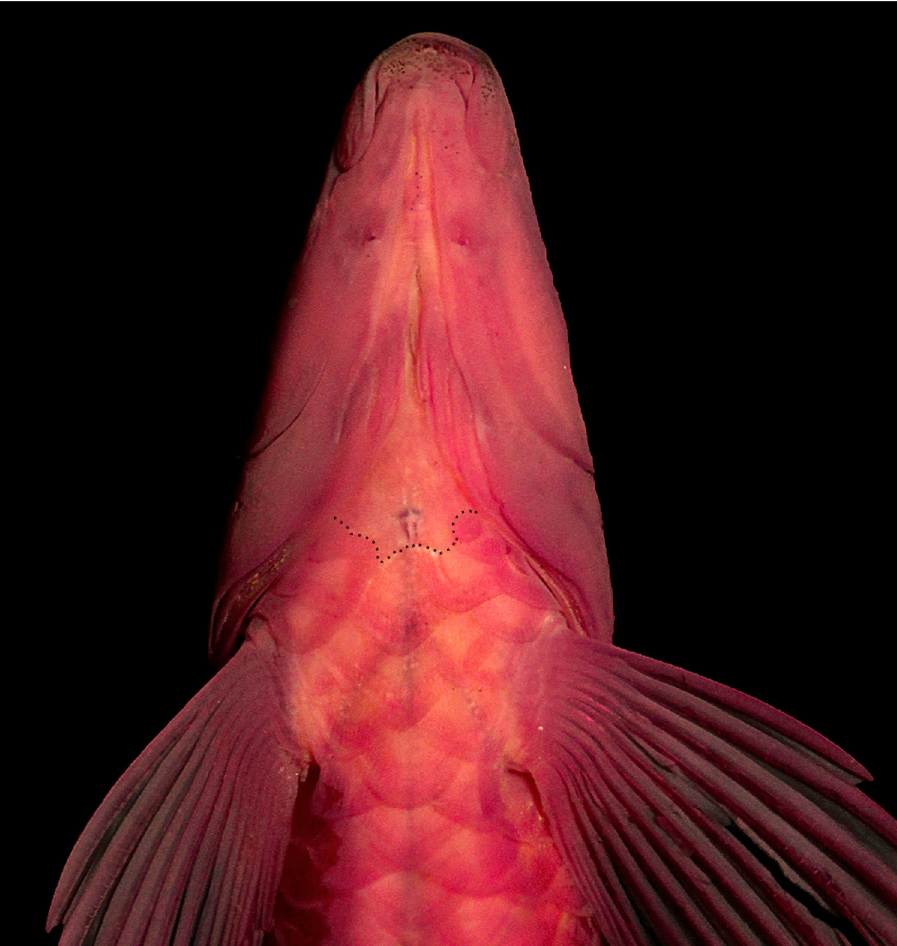
FIGURE 2 | Ventral squamation of Characidium krenak (MZUSP 112265, 36.9 mm SL, paratype) showing the lack of scales on a region of the isthmus not extending posterior to the anterior margin of the cleithrum (naked portion restricted to area anterior to the dotted